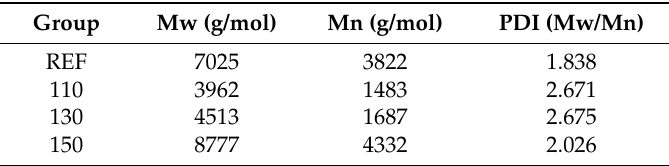
Table 2. Average molecular weight and molecular weight